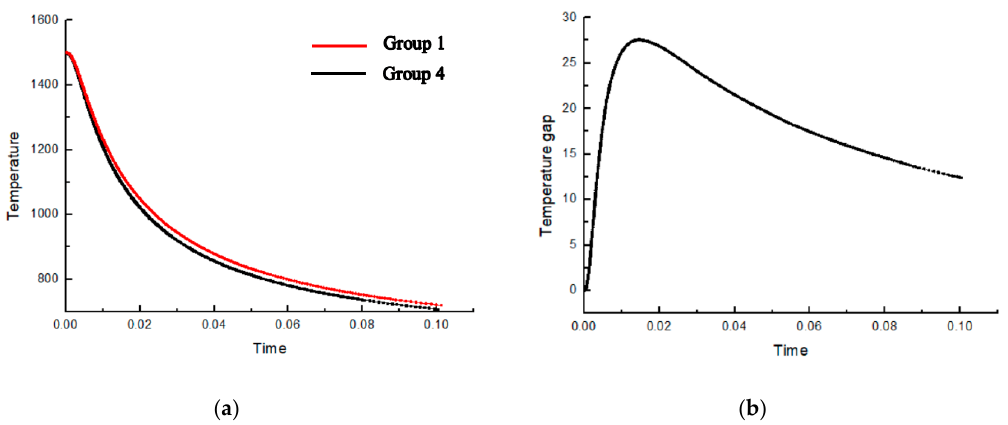
Figure 11. Temperature nephogram of samples with graphene after 1 s heat transfer.